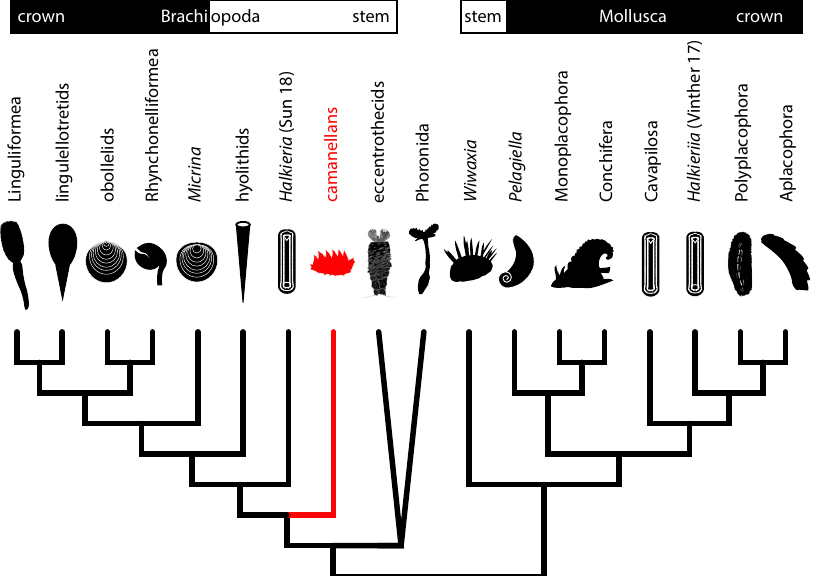
Fig. 7 Phylogenetic position of camenellans and other tommotiid clades among crown-brachiopods, -phoronids, -molluscs, and their respective stem lineages (modi fi ed from refs. 36,42 ). The common ancestor of the molluscan and brachiopod stem-lineages is likely reconstructed as a slug-like vermiform organism with multiple sclerites arranged in concentric zones. The differing phylogenetic positions for Halkieria re fl ect the contrasting interpretations Vinther et al. 33 and Sun et al. 42 , while the phylogenetic position of eccentrothecids and phoronids are presented as an unresolved consensus of recent studies 40,42,45